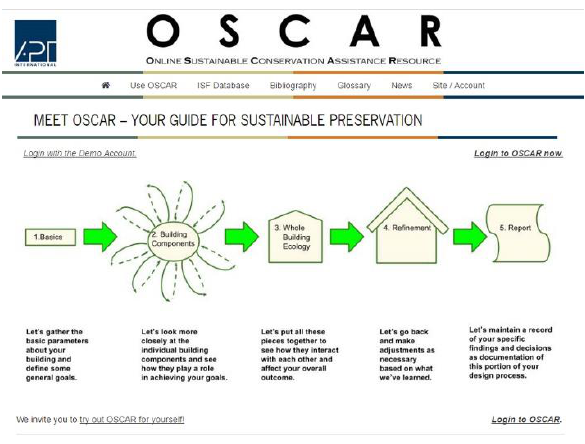
Figure 1. OSCAR 1.0 home